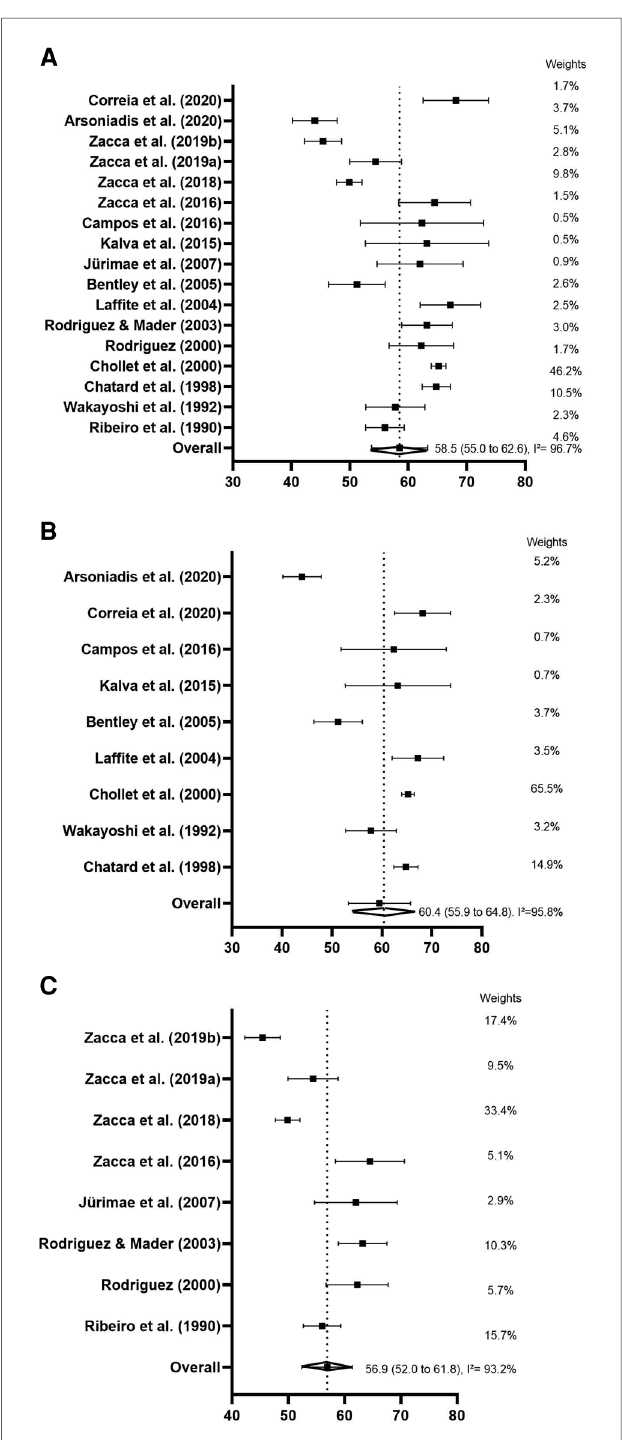
FIGURE 5 Forest plots and subgroups analysis ( A : mean overall VO 2 ; B : senior category and C : junior category, respectively) derived from continuous random-effects models depicting the energy parameters (VO 2 : oxygen consumption expressed in ml·kg − 1 ·min − 1